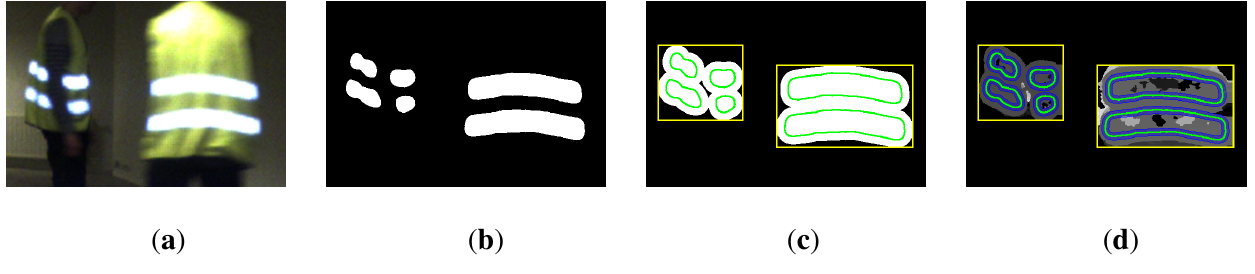
Figure 8. Disparity computation for a set of foreground blobs: ( a ) Observed scene as captured by a color camera; ( b ) Segmented foreground image I ; ( c ) Connected foreground s clusters obtained after morphological dilation. The bounding rectangles (yellow) indicate the area in which dense stereo matching is performed. The original contours of the blobs are drawn in green; ( d ) The final disparity image. The blue zone around the blob contour indicates the area in which disparity values are aggregated to obtain an overall disparity estimate per blob. Black areas within the bounding rectangles indicate regions where the matching fails, due to weak texture. Deviating gray levels inside the blob region indicate erroneously estimated disparities due to mismatched